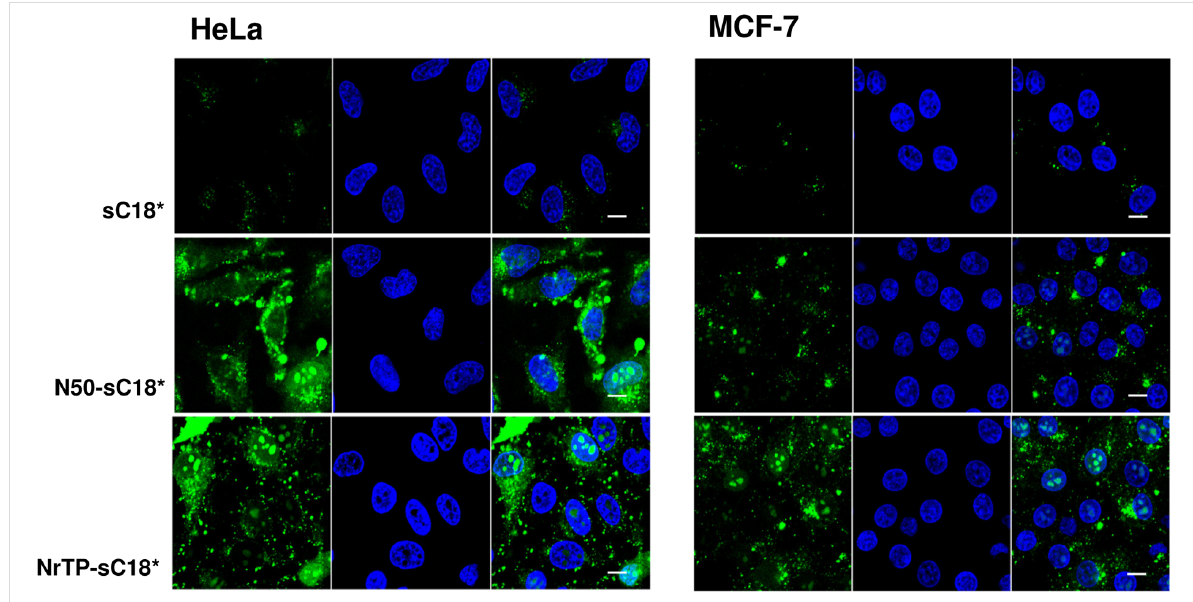
Figure 5: Distribution pattern of the peptides in HeLa and MCF-7 cells when incubating 10 µM CF-labeled peptide solutions for 120 min at 37 °C. Green: CF-labeled peptide; blue: Hoechst 33342 nuclear stain; scale bar is 10